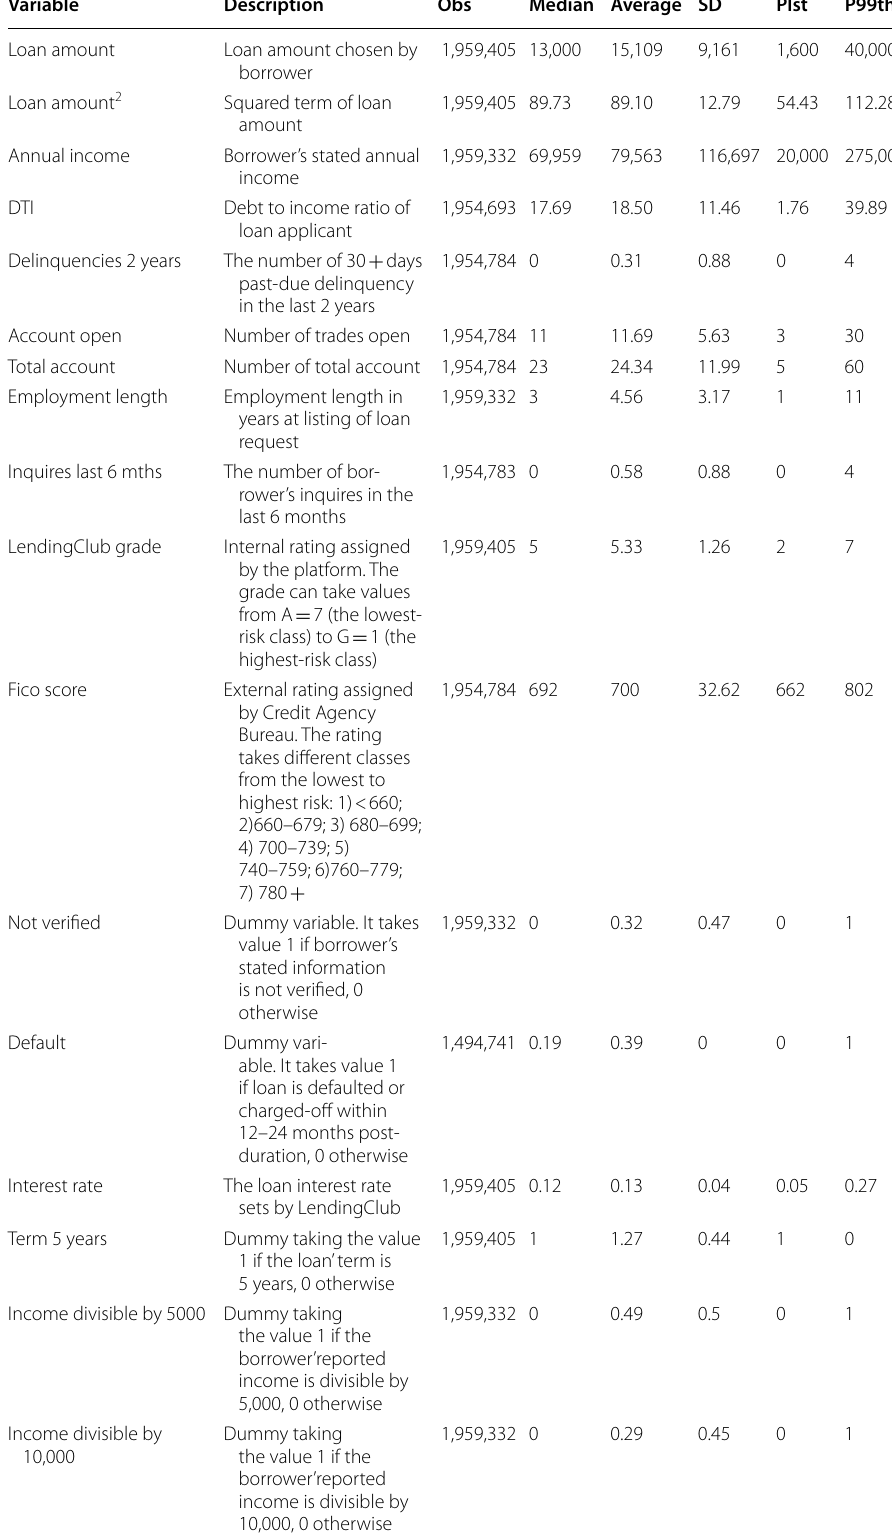
Table 1 Variable description and descriptive